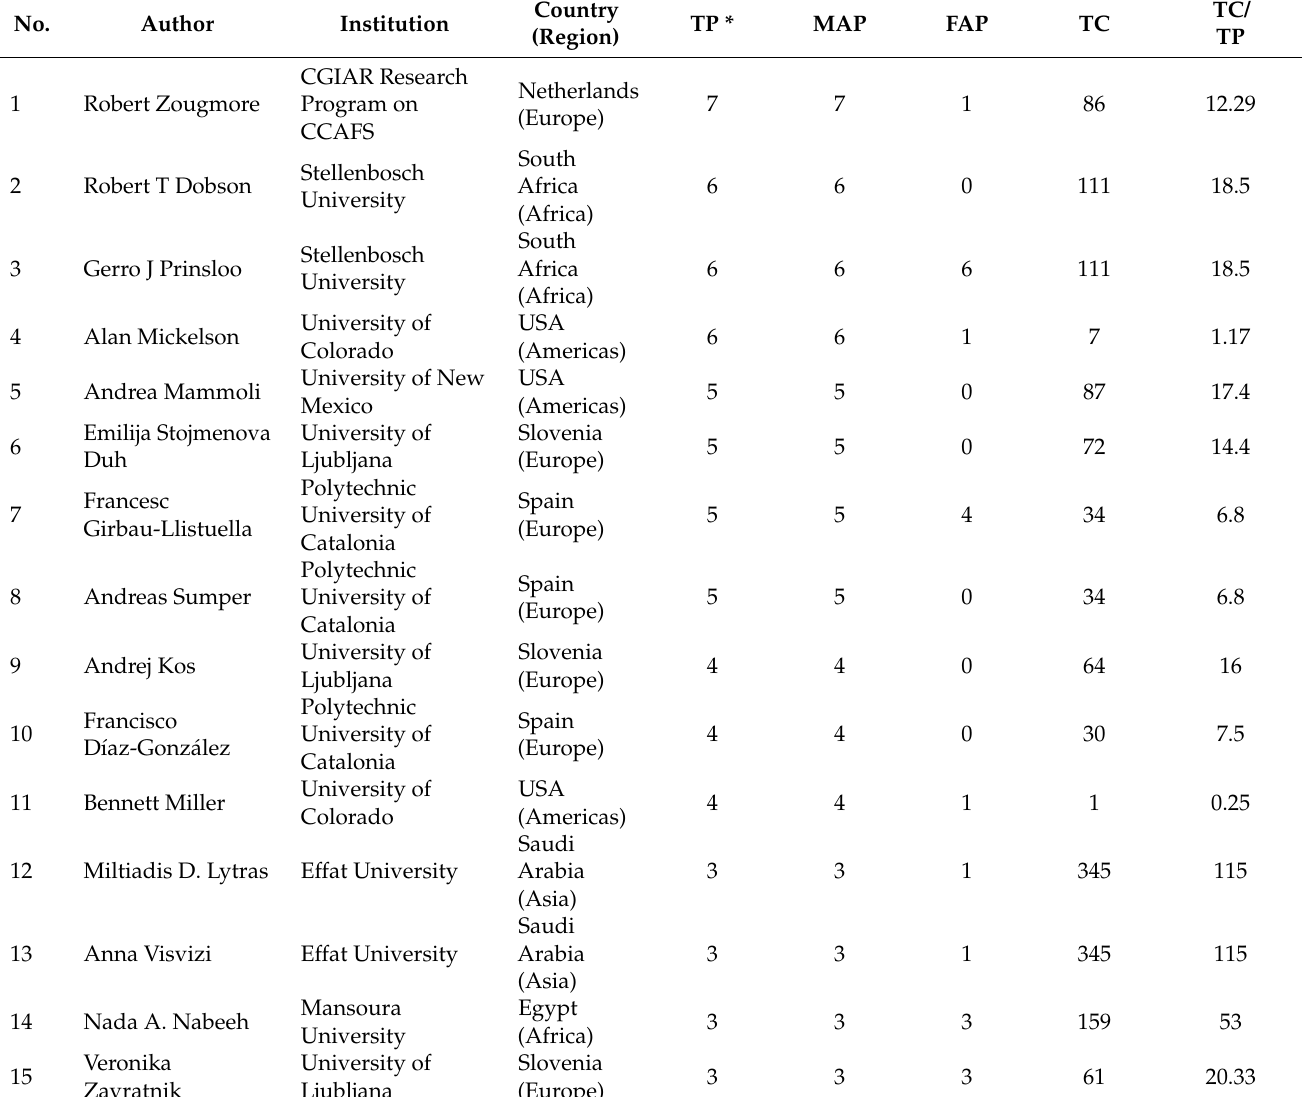
Table 4. Top 15 most relevant